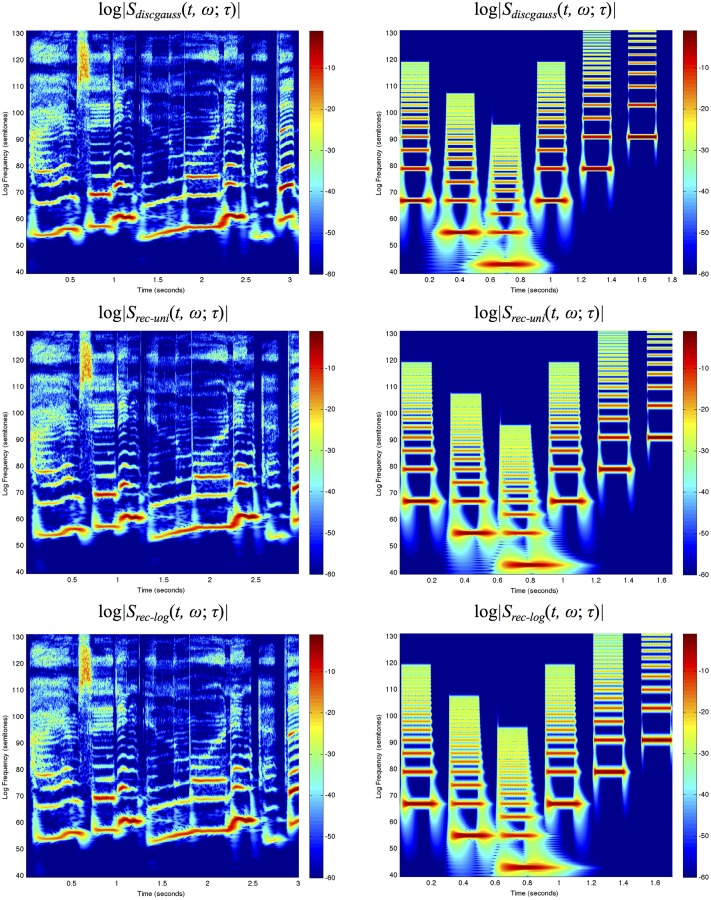

Spectrograms with the temporal window scale proportional to the wavelength according to
Equation (73) for n = 8 and a soft lower threshold σ0=τ0=1ms computed using different temporal scale-space concepts for (left column) the first 3 seconds of “Tom’s diner” by Suzanne Vega with the lyrics “I am sitting in the morning at the …” and (right column) a synthetic signal containing harmonic spectra with different ground tones over a logarithmic frequency range from 80 Hz to 16 kHz using 48 frequency levels per octave: (top row) the discrete analogue of the Gaussian kernel, (middle row) a cascade of seven time-causal recursive filters having a uniform distribution of the temporal scale levels and (bottom row) a cascade of seven time-causal recursive filters having a logarithmic distribution of the temporal scale levels with c=2.The vertical axis shows the logarithmic frequency expressed in semitones with 69 corresponding to the tone A4 (440 Hz). The spectrograms computed with time-causal kernels have been delay compensated by a temporal delay defined from the position of the first inflection point of the temporal window function. Notice that while the different types of spectrograms to some extent capture qualitatively similar types of spectro-temporal structures, there is a significant difference in temporal delay and temporal response characteristics between the non-causal and the time-causal spectrograms. Compared to the spectrograms in fig. 7 that are computed with a fixed temporal scale implying that the spectral bands become more narrow at higher frequencies, the use of a temporal scale proportional to the wavelength specifically implies that the widths of the spectral bands are here much more uniform over frequencies (see the section “Frequency selectivity of the spectrogram” for a theoretical analysis).